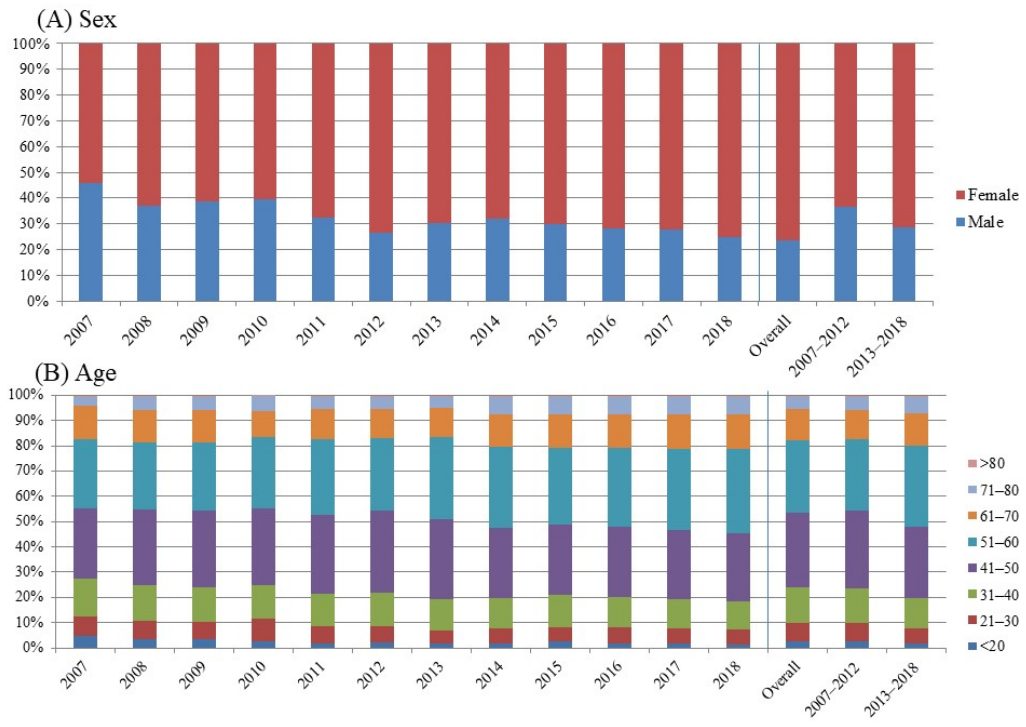
Figure 2. The distribution of rosacea visits by year of visit. ( A ) The distribution of rosacea visits by sex. ( B ) The distribution of rosacea visits by age .